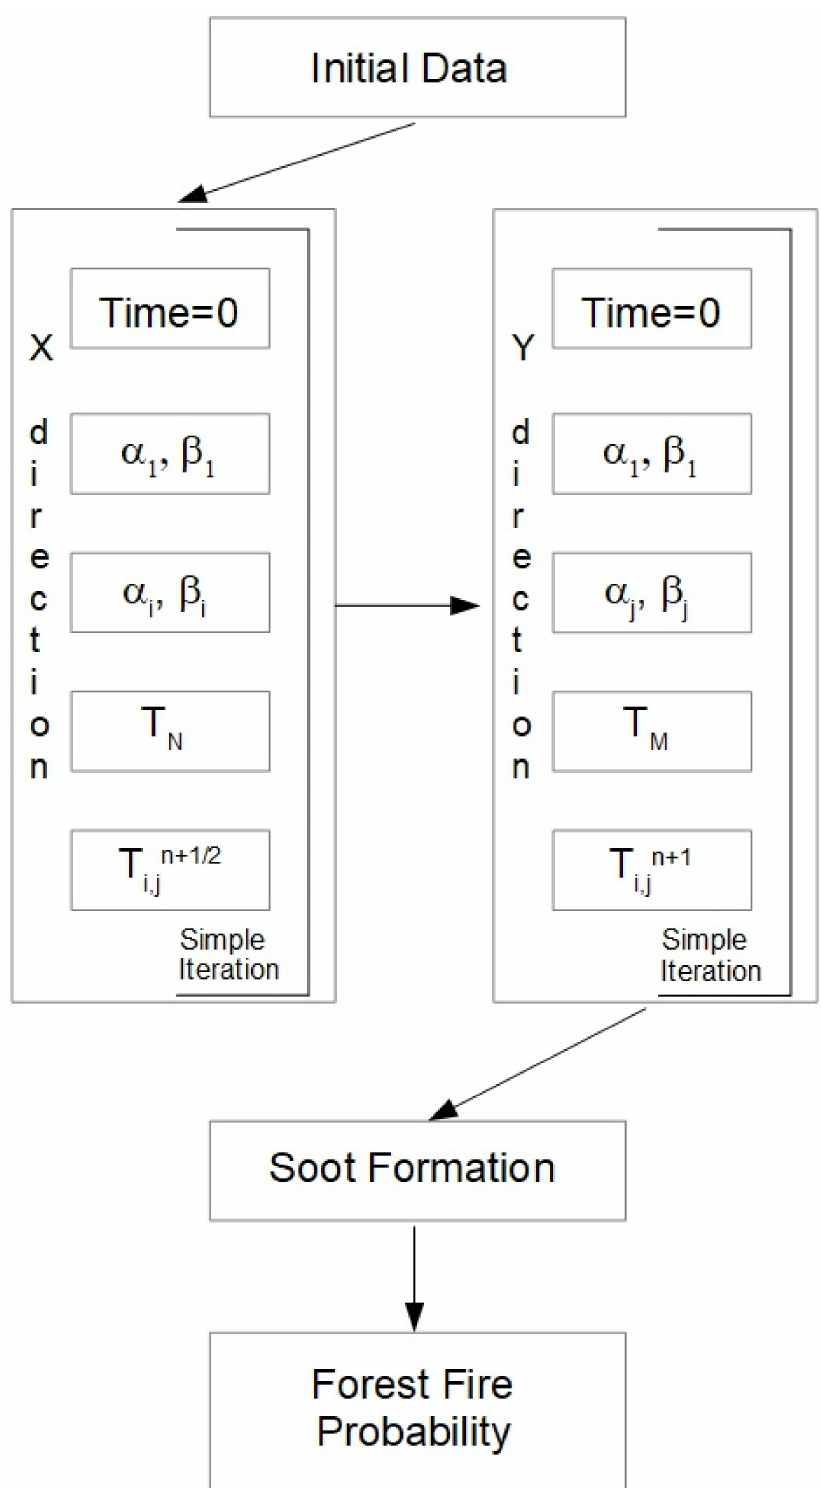
Figure 1. Scheme of the algorithm for calculating the probability of a forest fire. The next block allows you to calculate the probability of a forest fire from lightning activity, taking into account soot particles. The probabilistic characteristic of the occurrence of a forest fire from a thunderstorm front, which in turn arises from various factors, one of which is an aerosol particle, namely soot, is